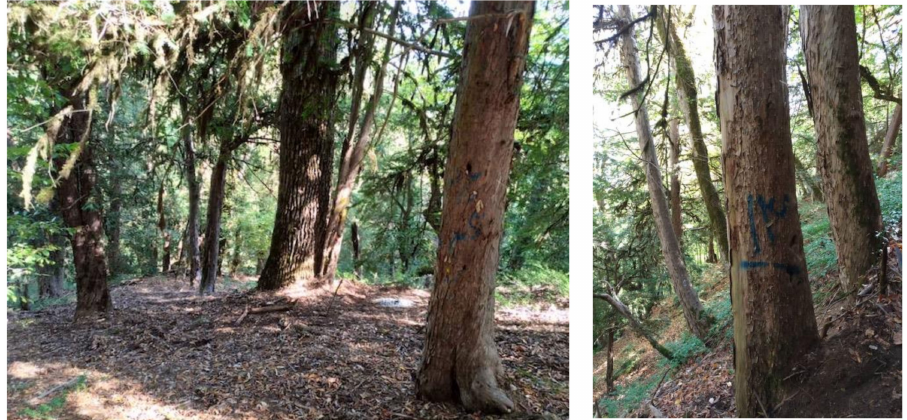
Figure 1. Impressions of the field plots with large Taxus baccata and Quercus castaneifolia trees assessed in the course of this study (Photos by Seyed Jalil